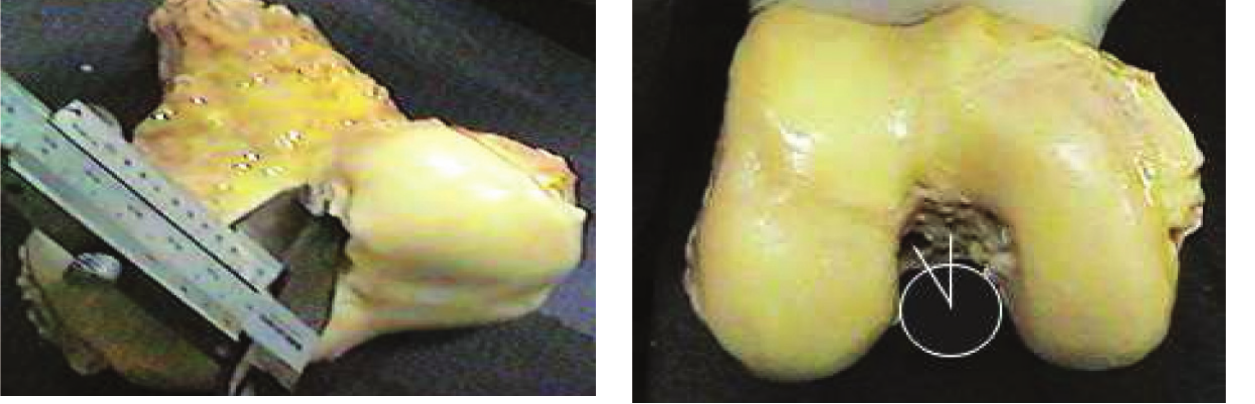
Figure 3 – Tunnel entrance in the intercondyle notch.